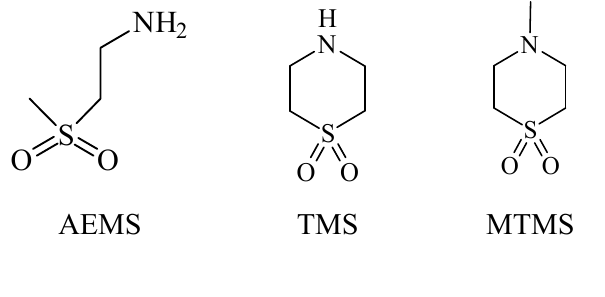
Figure 13. Structures of 2-aminoethylmethylsulfone (AEMS), thiomorpholine 1,1-dioxide (TMS) and N -methylthiomorpholine 1,1-dioxide